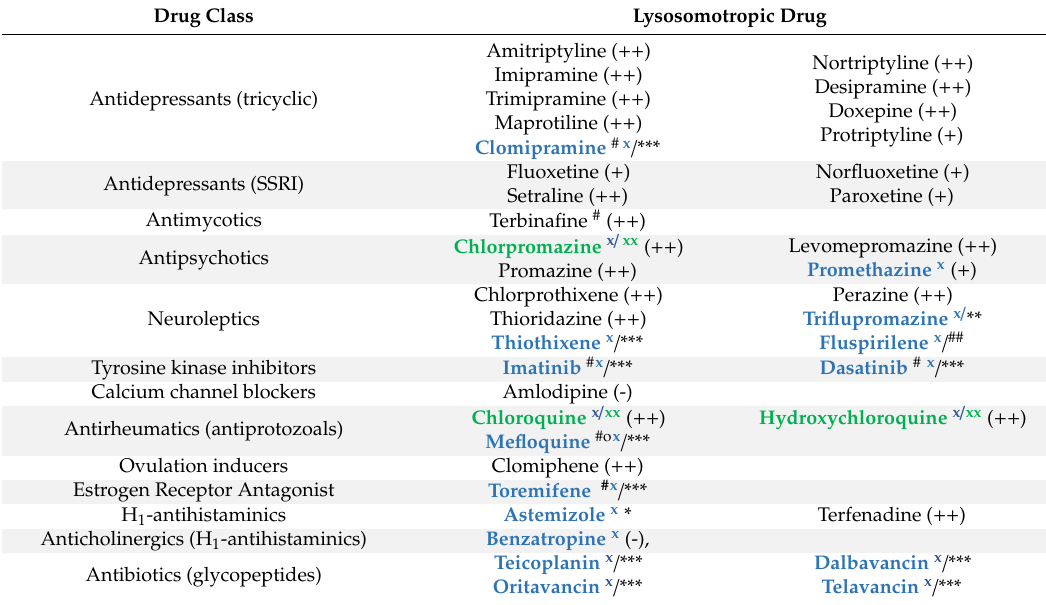
Table 1. Variety of approved lysosomotropic compounds for various indications